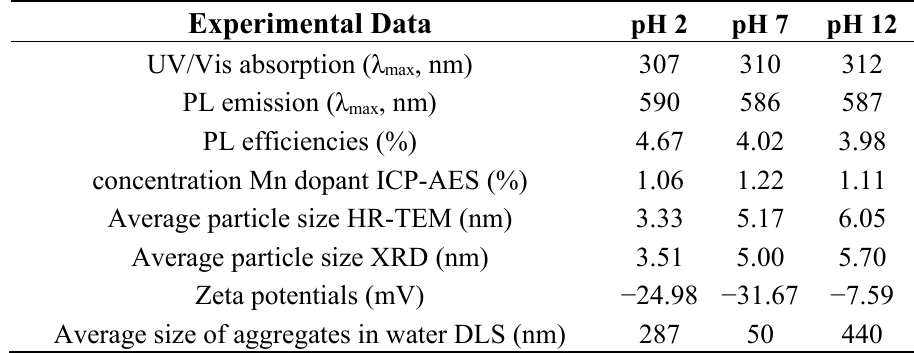
Table 2. Experimental data summary of ZnS:Mn-MAA NCs prepared at different pH